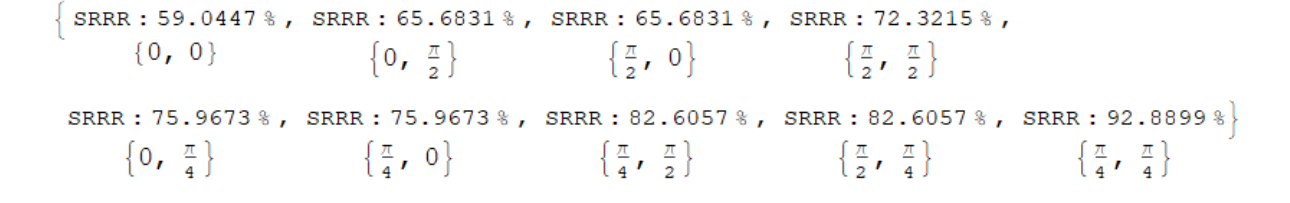
Figure 6. Solar Radiation Reception Rate for m = 2 and n = 2 at the equinox in the region of Makkah, Saudi Arabia.